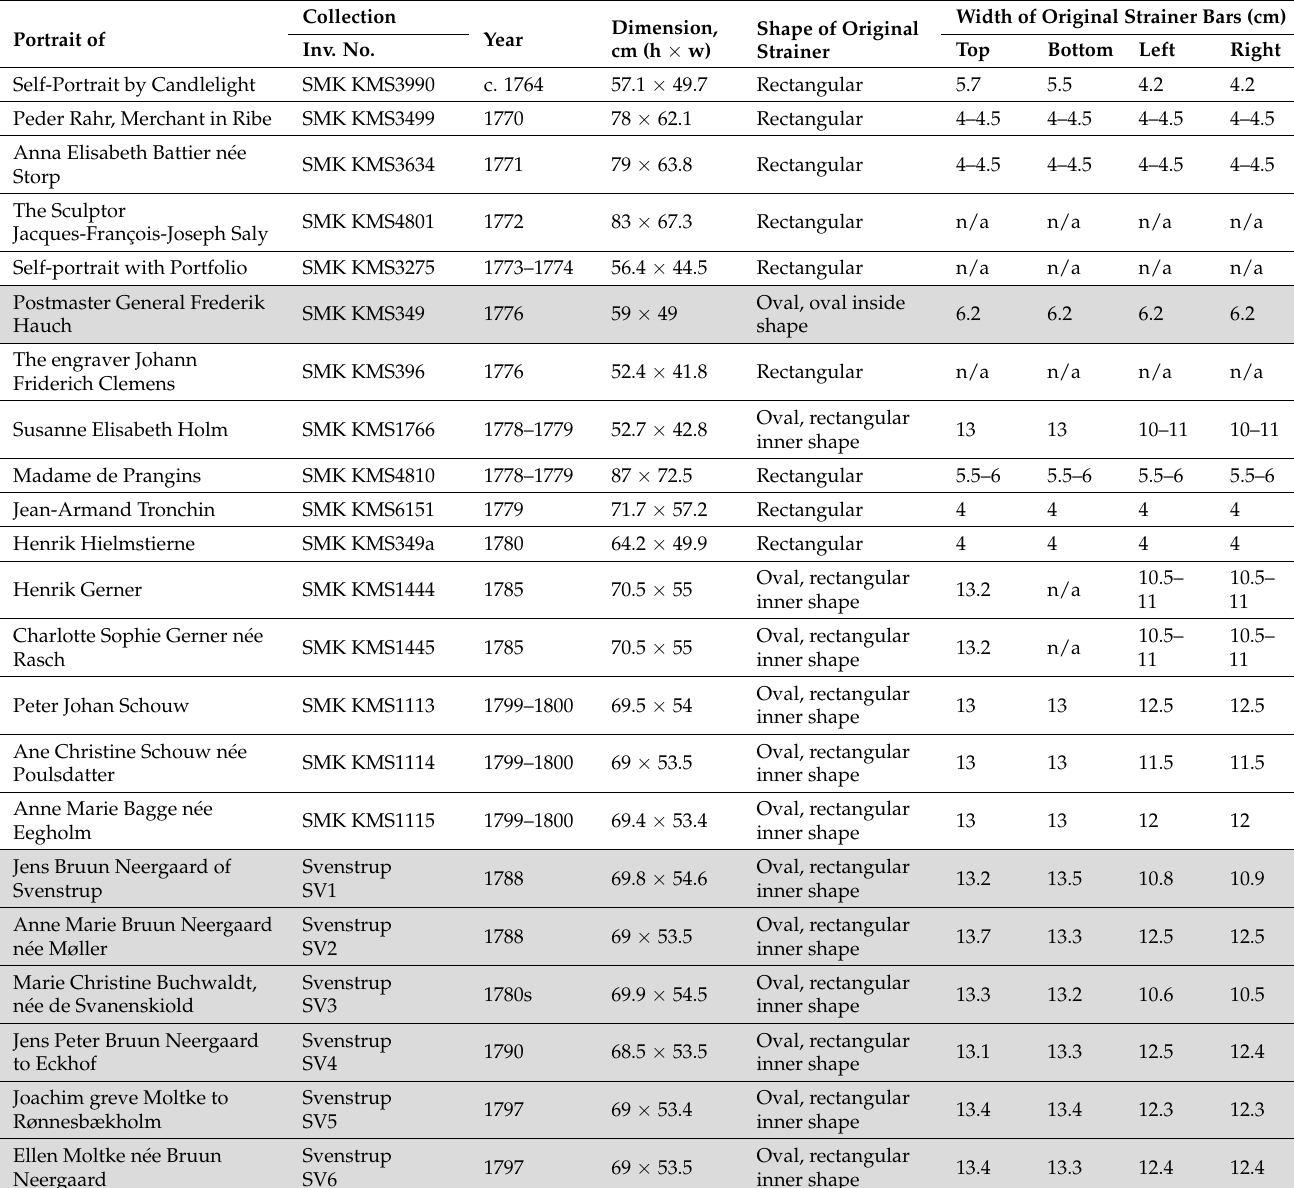
Table 1. Overview of information regarding original strainers of the twenty-two paintings by Jens Juel included in this study. Where marked in grey, the painting remains mounted on the original